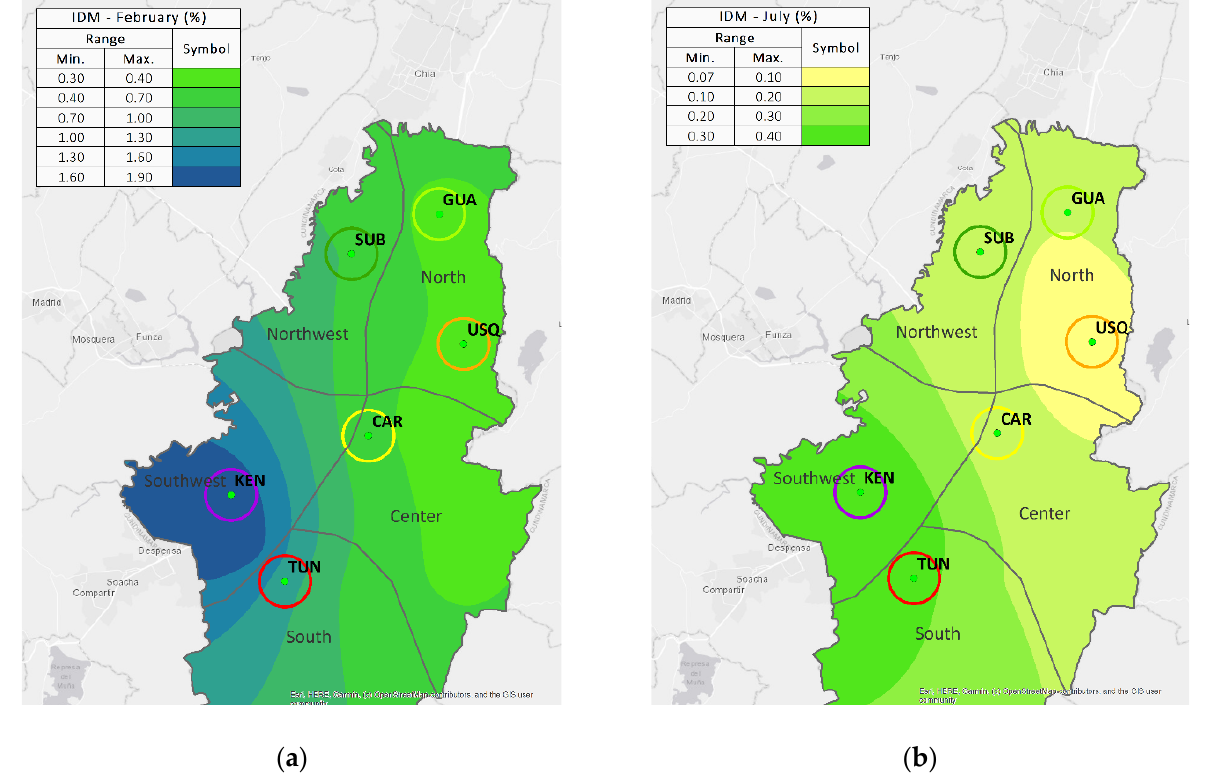
Figure 6. Average spatial variation of IDM during ( a ) the most critical month (February) and ( b ) the least critical month (July), by PM 10 concentrations.